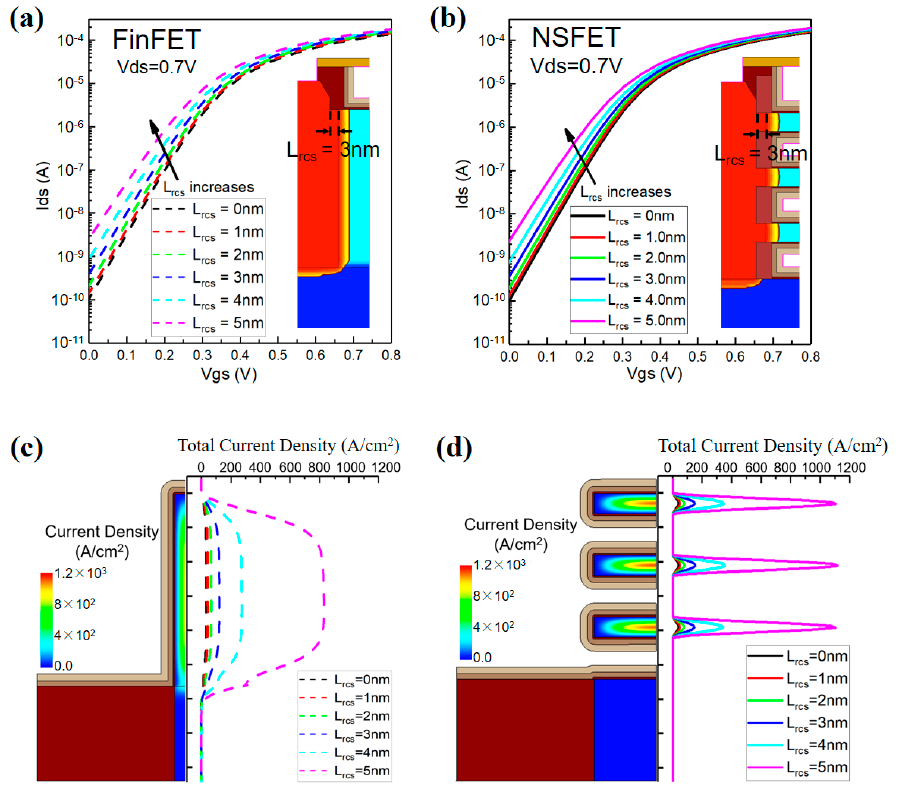
Figure 3. Id-Vg curves @ Vds = 0.7 V of ( a ) FinFET and ( b ) NSFET. Inset: Fin and NS FET devices with 3 nm L rcs . Leakage current density profiles (Vgs = 0 V and Vds = 0.7 V) of ( c ) FinFET and ( d ) NSFET at 5 nm L rcs .